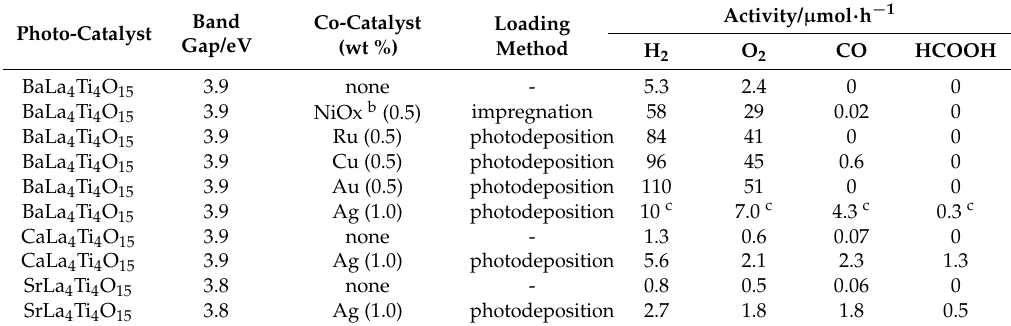
Table 4. CO 2 reduction over ALa 4 Ti 4 O 15 (A = Ca, Sr and Ba) photocatalysts with various co-catalysts a [39].